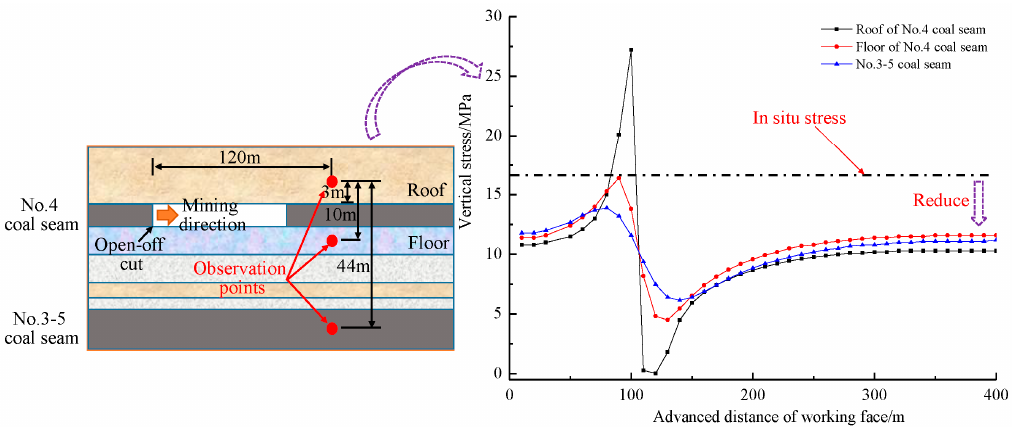
Figure 4. Vertical-stress distribution of different layers while mining the No. 4 coal seam.